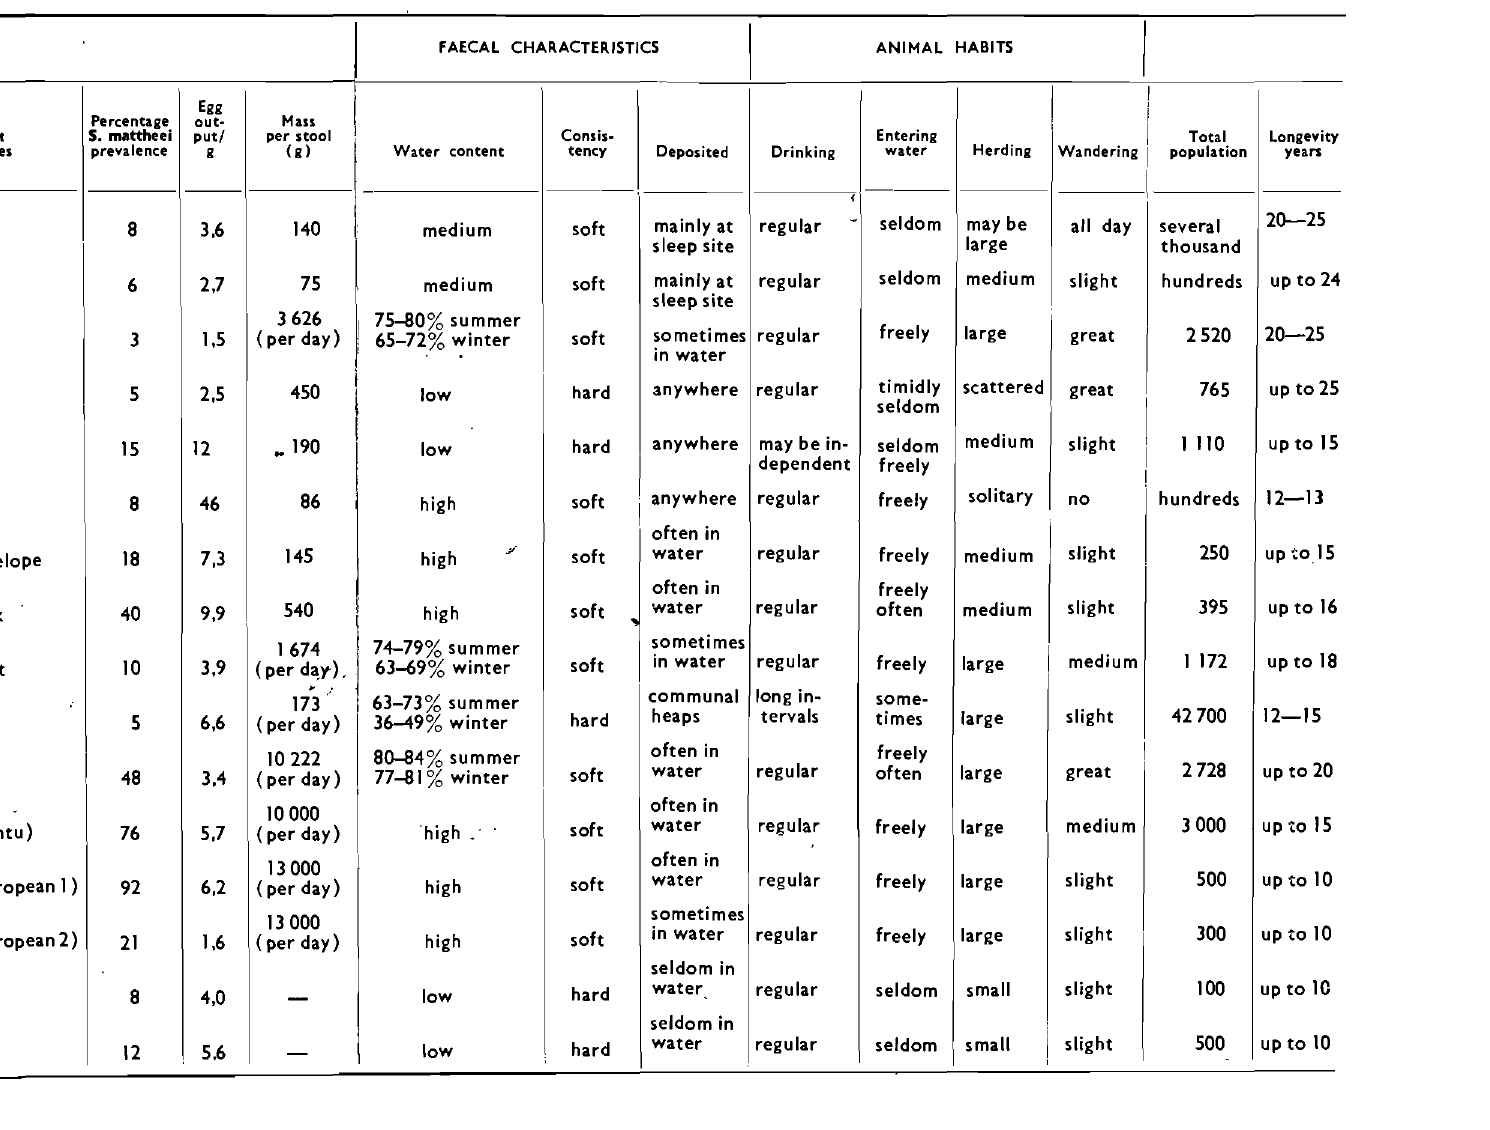
Table 11: CHARACTERISTICS OF DEFINITIVE HOSTS RELATING TO